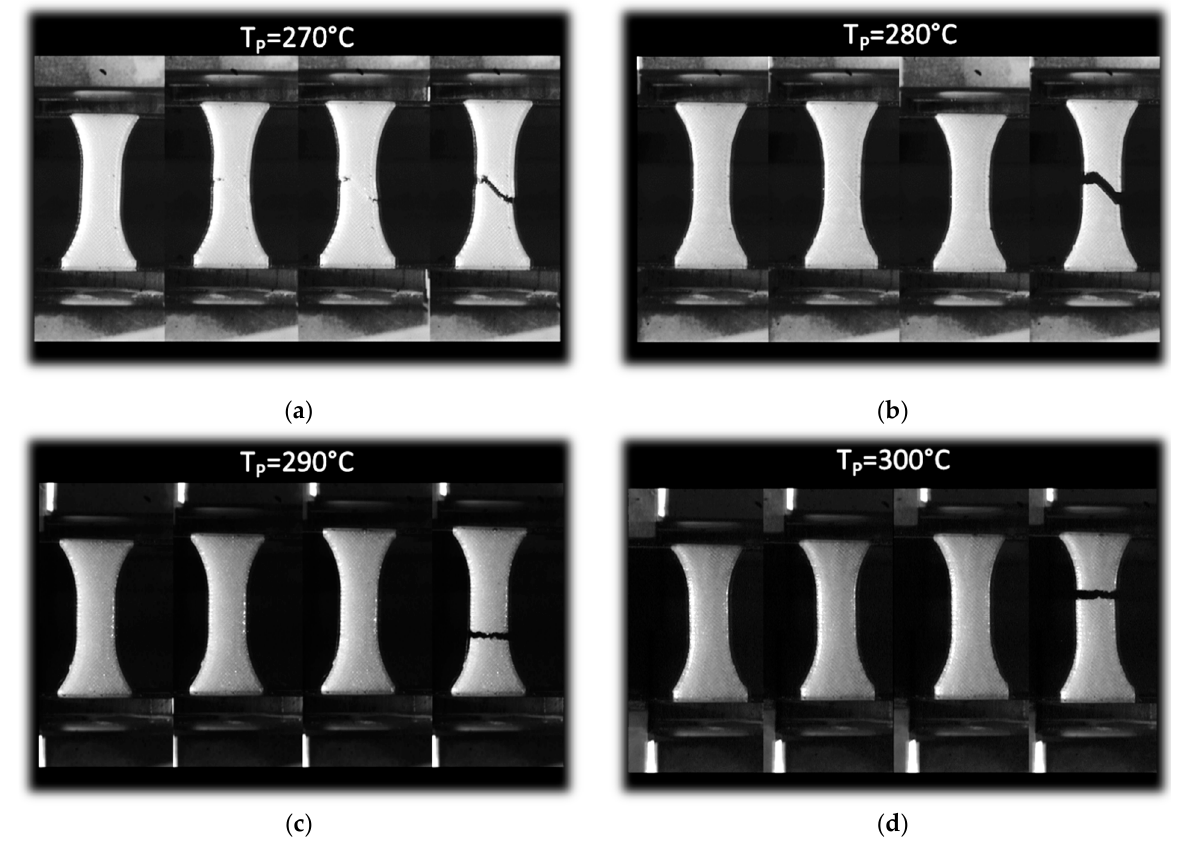
Figure 8. Typical optical recording of tensile response of 3D printed PC samples as a function of printing temperature T P : ( a ) 270 °C; ( b ) 280 °C; ( c ) 290 °C; ( d ) 300 °C. Table 4. Thermal properties of 3D printed PC as a function of the in-fill ratio. The printing temperature is 280 ◦